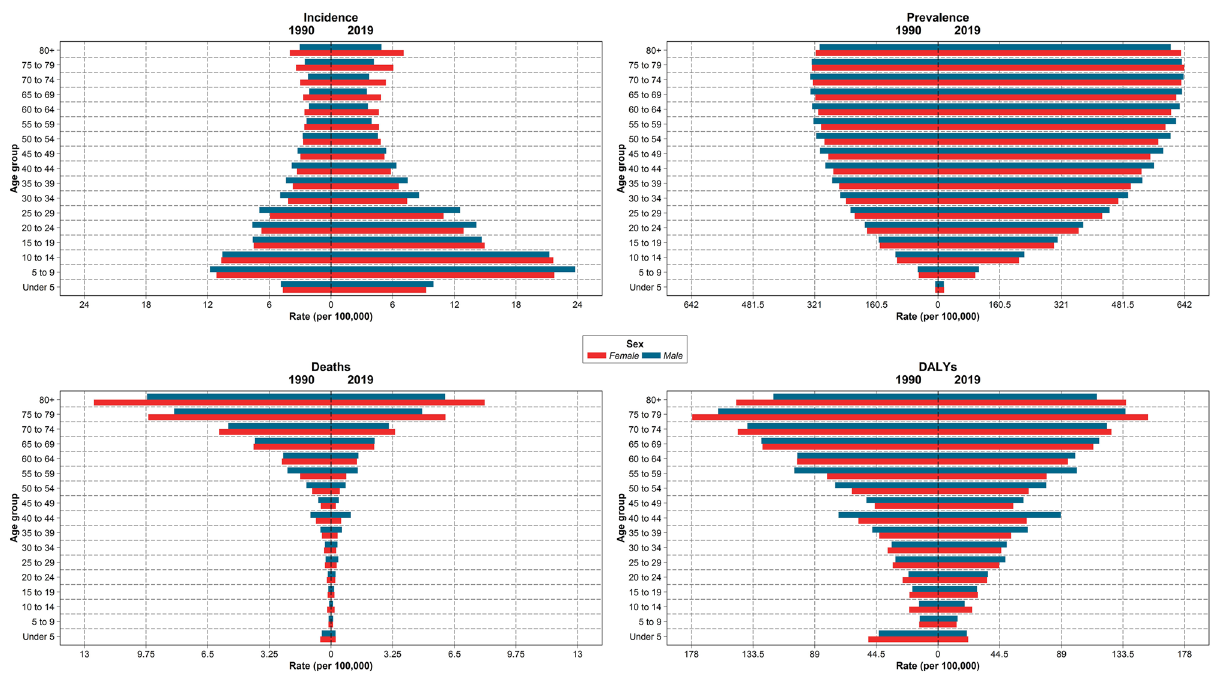
Figure 5. Burden of T1DM in the country by sex and age groups in 1990 and